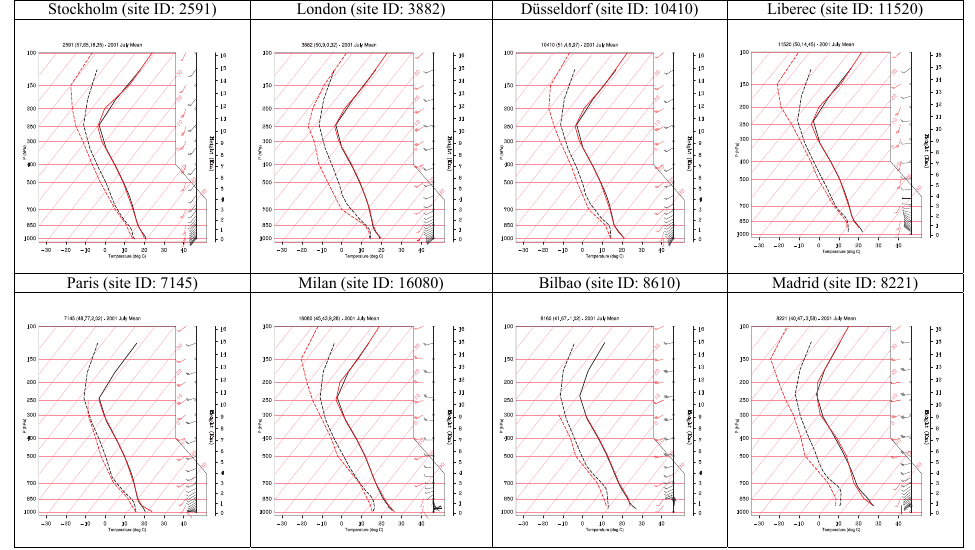
Figure 19. Monthly mean observed and simulated skew-T plots of temperature (red solid and black solid lines, respectively), dew point temperature (red dash and black dash lines, respectively), and wind speed and direction (red and black staffs and attached barbs, respectively, with a triangle, a long barb, and a short barb perpendicular to the overall staff representing 50, 10, and 5 knots, respectively) at eight stations over D01 in July, 2001.